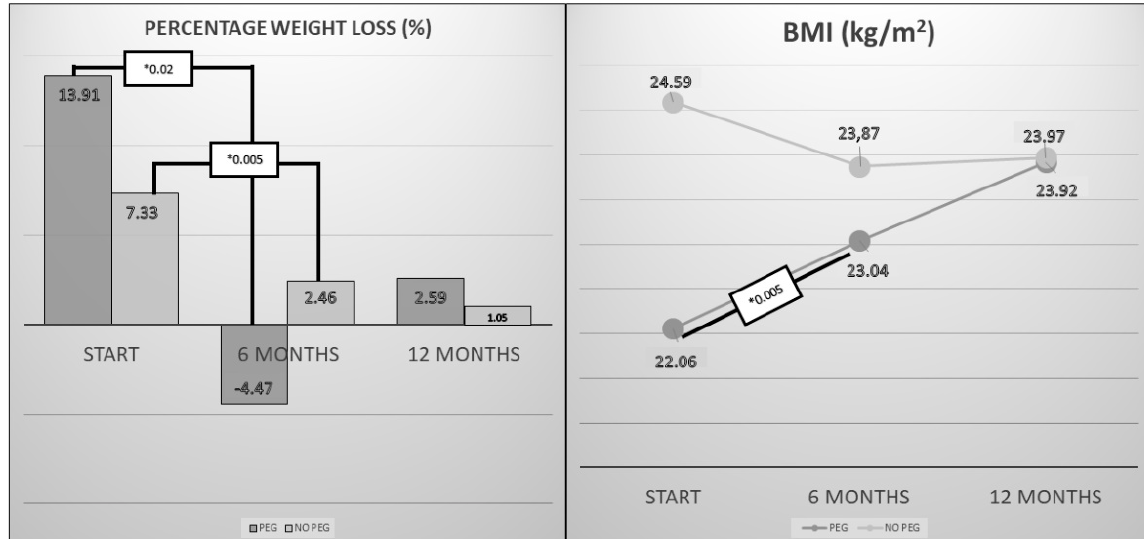
Figure 2. Changes in the percentage of weight loss and body mass index (BMI) since the start of nutritional support in those patients with Percutaneous Endoscopic Gastrostomy (PEG) from the start and those who did not. * p < 0.05. A PEG was implanted early (less than 10 months after diagnosis) in 19 patients (50%); while it was implanted late (more than 10 months after diagnosis) in 19 patients (50%) (Table 2). Table 2. Differences between Percutaneous Endoscopic Gastrostomy (PEG) before (PEG < 10 months) and after 10 months (PEG > 10 months) since diagnosis of ALS. M, male; F, female; ALS, amyotrophic lateral sclerosis; BMI, body mass index; SGA, subjective global Table 2. Multivariate analysis of the probability of survival over 15 months over variables age, type of ALS, PEG implan- tation and nutritional status measured by SGA.